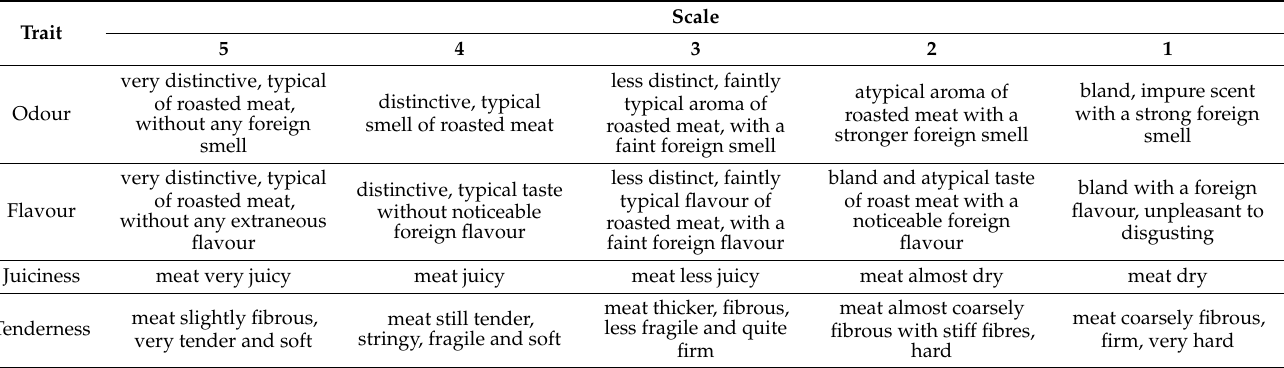
Table 2. Scale for sensory evaluation of